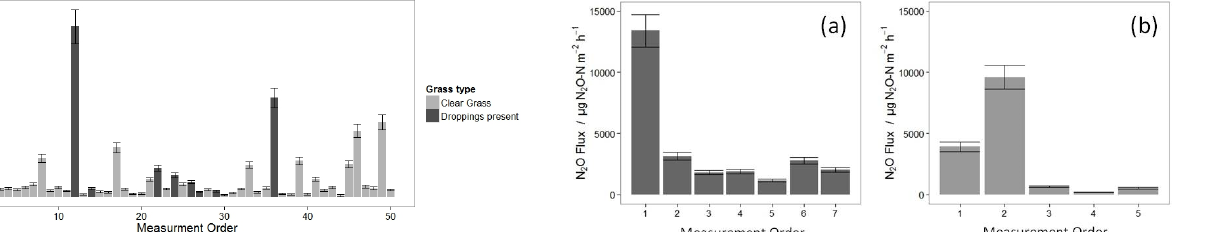
Figure 3. (a) Flux measurements made on patches of decayed grass silage. Measurements 1–3 were taken from the first patch (referred as S1 in Fig. 1) and the remaining four were measured from the sec- ond (referred as S2 in Fig. 1). (b) Flux measurements made from a shaded area with increased sheep density. The first two of these measurements were made near the centre of the shaded area. Fluxes from both features were made during the same 3-day measurement period between 8 and 10 July 2013. Error bars represent the uncer- tainty in flux measurement calculated using a propagation of errors from regression, volume, temperature and